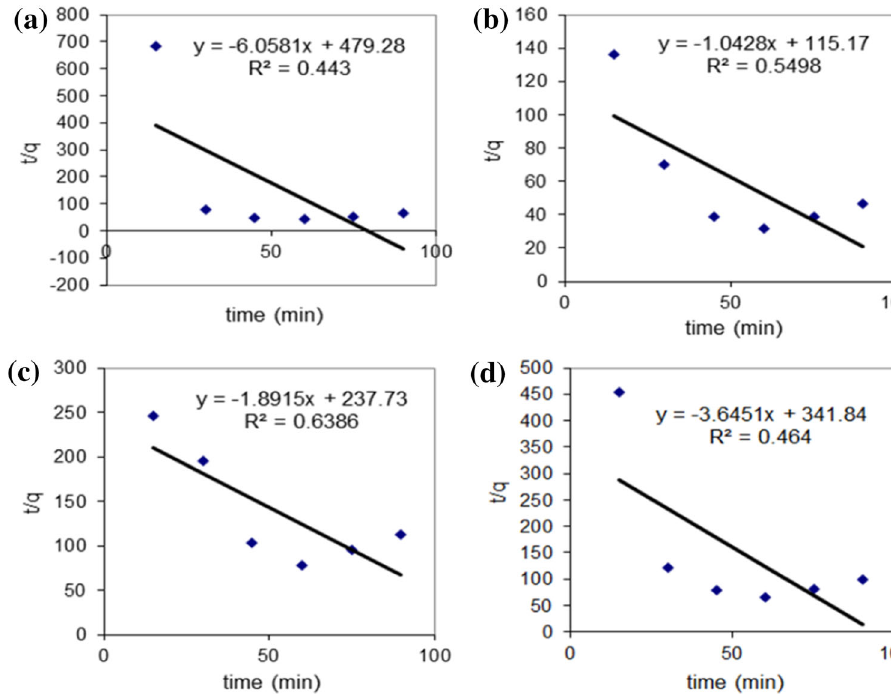
Fig. 11 Pseudo-second-order